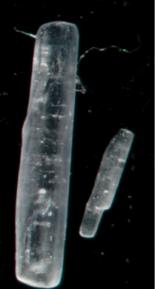
Figure 1. Light microscope image of two representative isoniazid crystals, B1 left and B2 right. Magnification: 2.5 × .